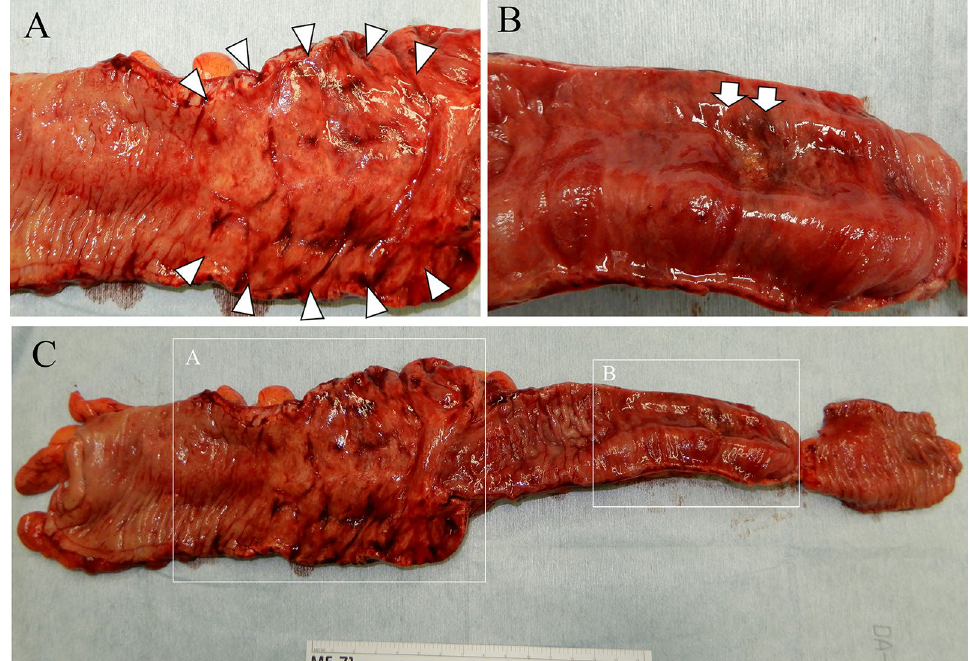
Fig. 5 A Extensive mucosal erosions were found in the ascending colon to cecum (arrowhead), same lesion in Figs. 2A and 3A. B Deep longitudinal ulceration were observed in the terminal ileum (arrows), same lesion as in Figs. 2B, 3B and 4B. C A 30 cm terminal ileum with a hemorrhagic ulcer lesion and a 20 cm cecum to ascending colon with erosions were resected